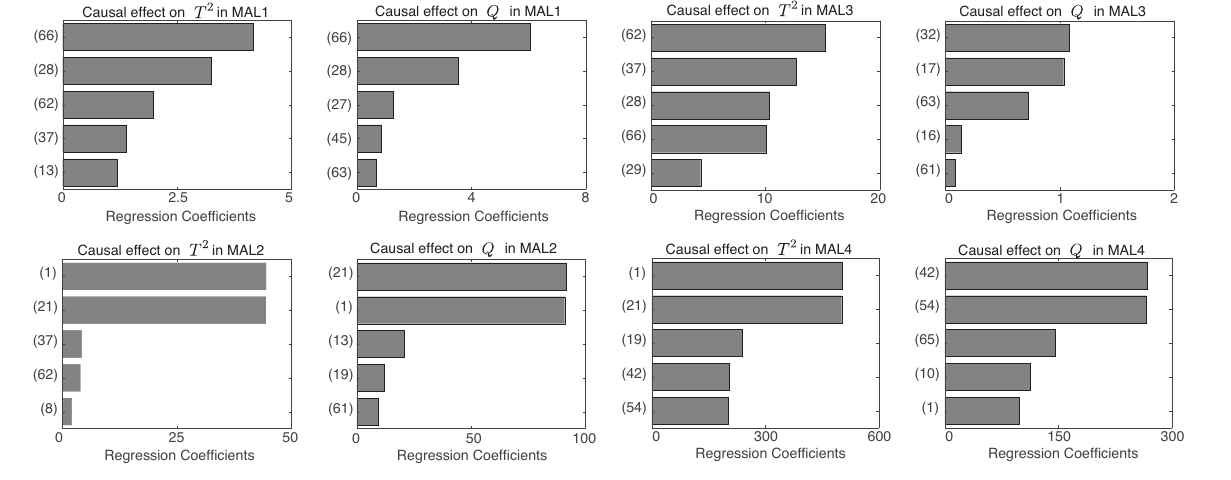
Figure 5. Fault diagnosis results in VAM process by causal plot. Table 3. Summary of fault diagnosis results in VAM